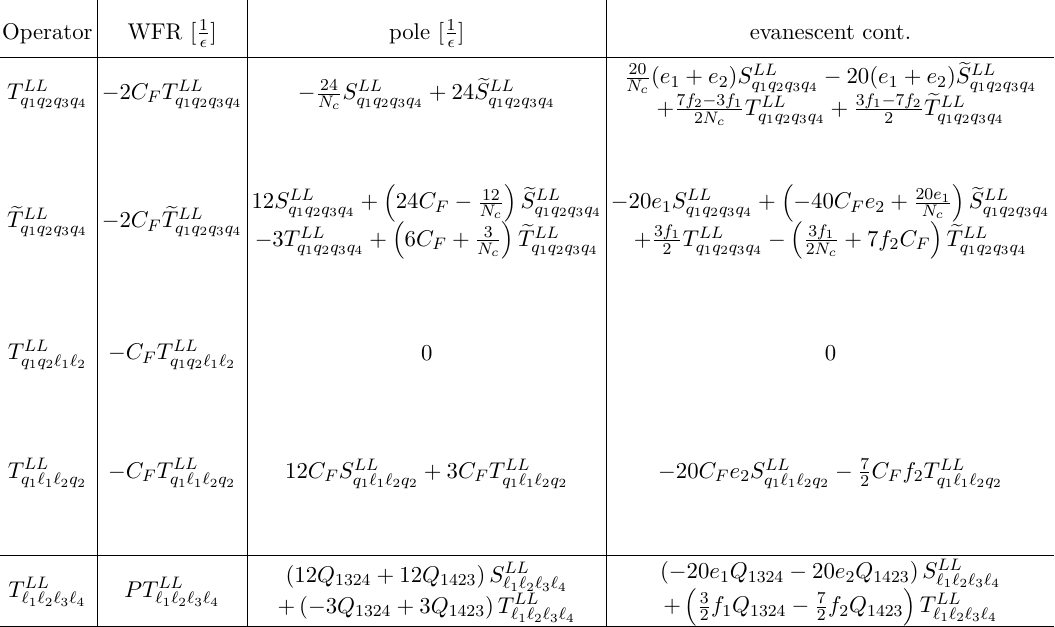
Table 14. Loop structure for σ µν P L ⊗ σ µν P L operators: the columns correspond to the divergent WFR contributions and vertex corrections as well as the finite contributions from evanescent op- erators, computed in the generalised BMU scheme. The first four rows result from QCD and are given in units of α s / (4 π ) whereas the last one is a QED correction given in units of α/ (4 π ) .